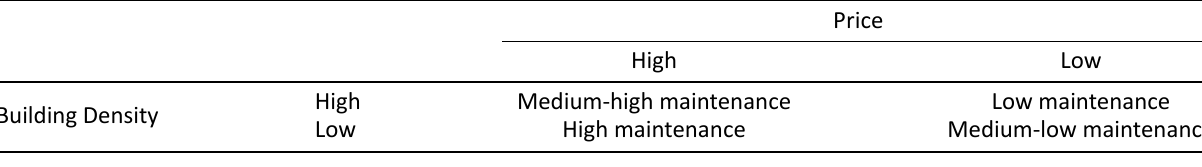
Table 2. Quadrants of maintenance